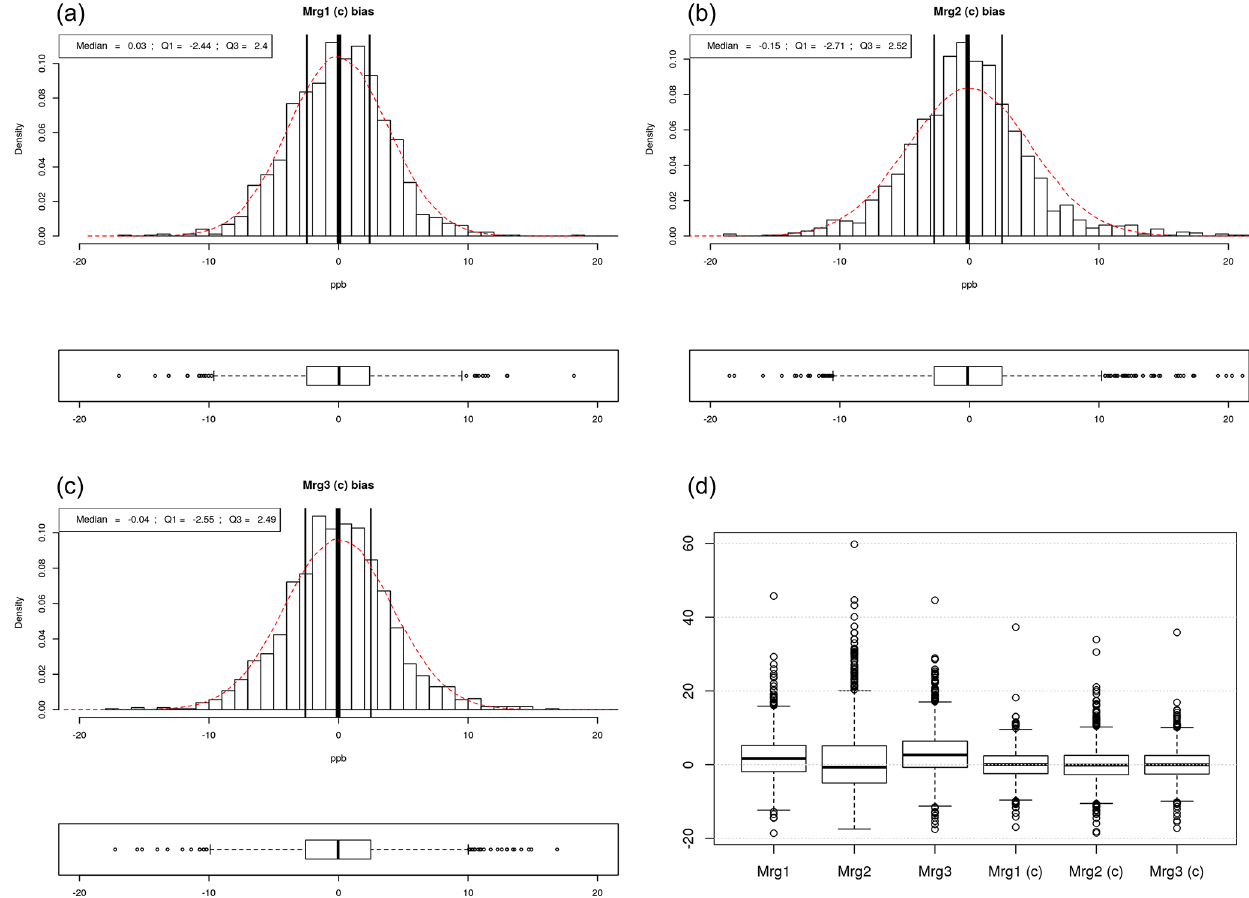
Figure 6. (a) Bias between the reference instrument and the Mrg1 sensor after the LCS correction, (b) bias of the Mrg2 sensor after LCS correction, (c) bias of the Mrg3 sensor after correction and (d) comparison of the LCS bias before and after